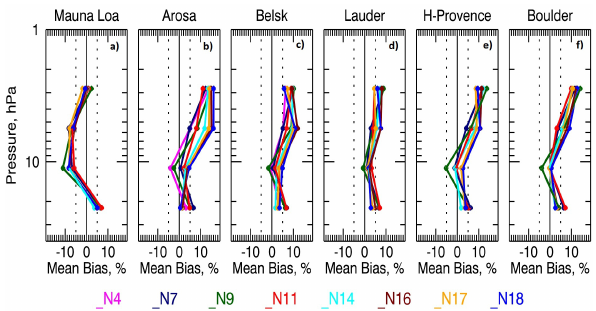
Fig. 8. Same as Fig. 6, but relative to ground-based Umkehr mea- surements at (a) Mauna Loa, (b) Arosa, (c) Belsk, (d) Lauder, (e) Haute Provence and (f)